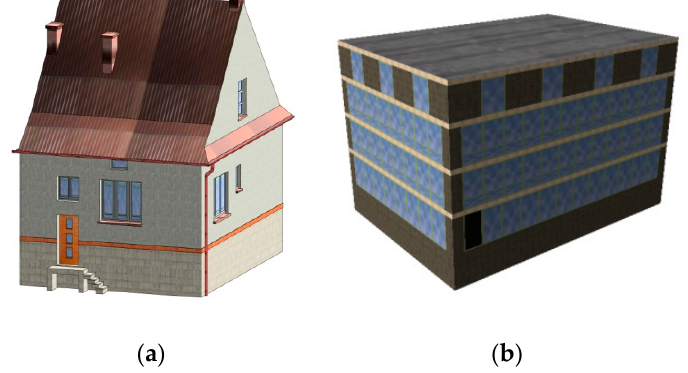
Figure 3. Example of ( a ) an existing building; ( b ) a planned 3D object. Source: own work.